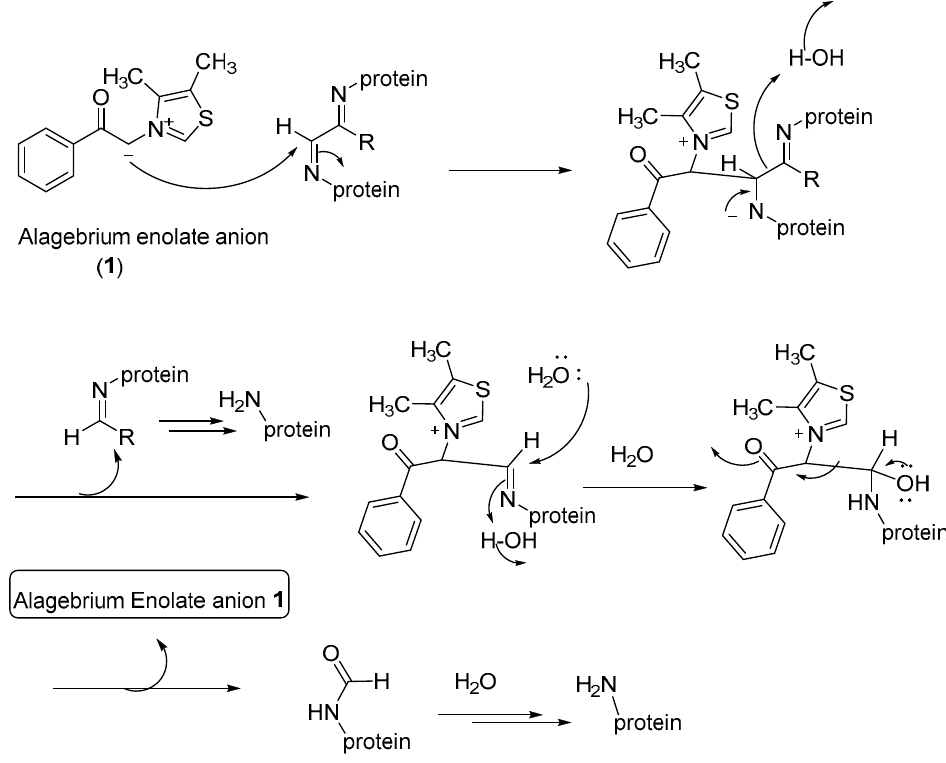
Figure 12. Proposed mechanism for the AGE-breaker-mediated hydrolysis of protein crosslinks. The thiazolium moiety in PTB and Alagebrium and the pyridinium moiety in TRC-